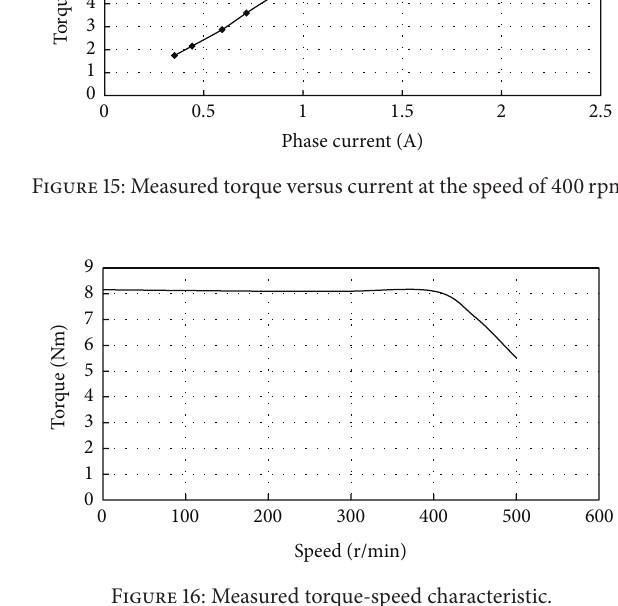
Figure 16: Measured torque-speed